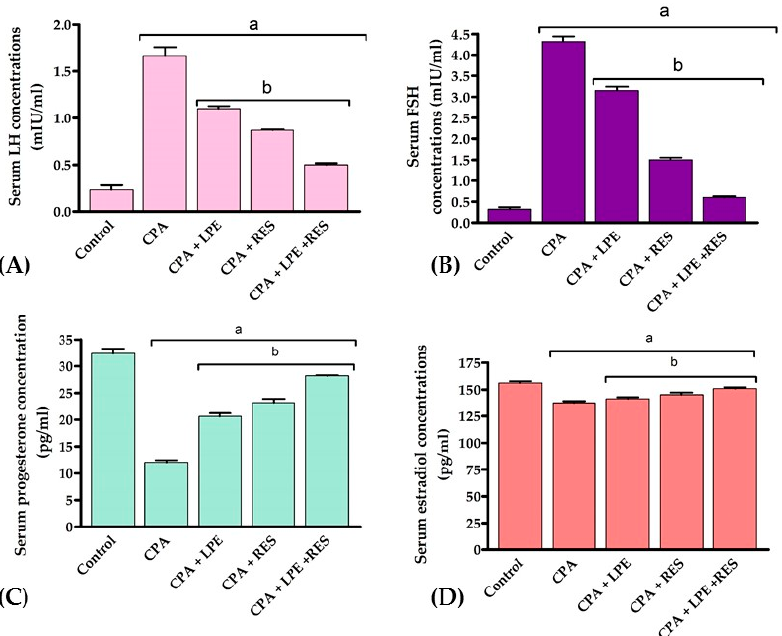
Figure 1. Effects of LPE and/or RES on the serum hormonal markers of cyclophosphamide-treated rats. ( A ) LH concentration, ( B ) FSH concentration, ( C ) Progesterone concentration, ( D ) Estradiol concentration. Data expressed as mean ± SEM, a p < 0.05 versus the control group; b p < 0.05 versus a CPA group, (n = 7). CPA: Cyclophosphamide, LPE: Lemon peel extract, RES: resveratrol. Molecules 2022 , 27 , x FOR PEER REVIEW 2.2. Effect of LPE and RES on the Serum Antioxidants and Oxidative Stress Markers of Cyclophosphamide-Treated Rats Figure 2 reveals that the levels of MDA were significantly upregulated ( p < 0.05) with a large drop in GSH level and SOD activity after CPA treatment contrasted with a negative group. Treatments with LPE, RES, or LPE + RES significantly downregulated ( p < 0.05) the MDA levels while significantly elevating the GSH level and SOD activity, compared with